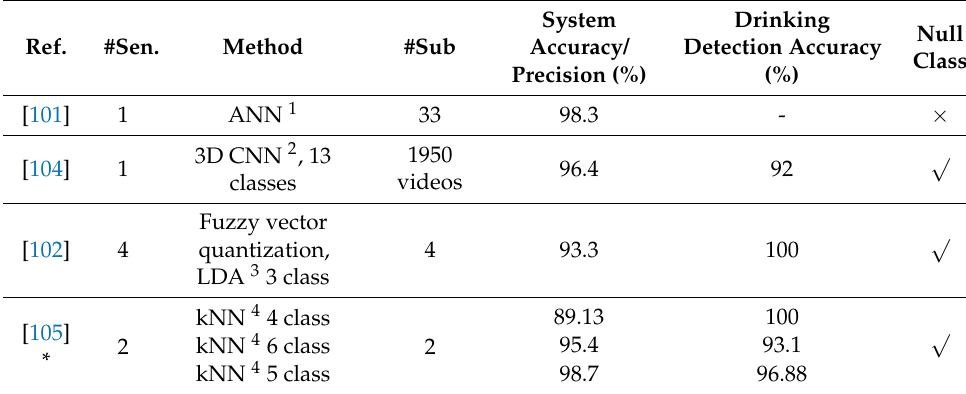
Table 3. Summary of vision- and environmental-based literature.